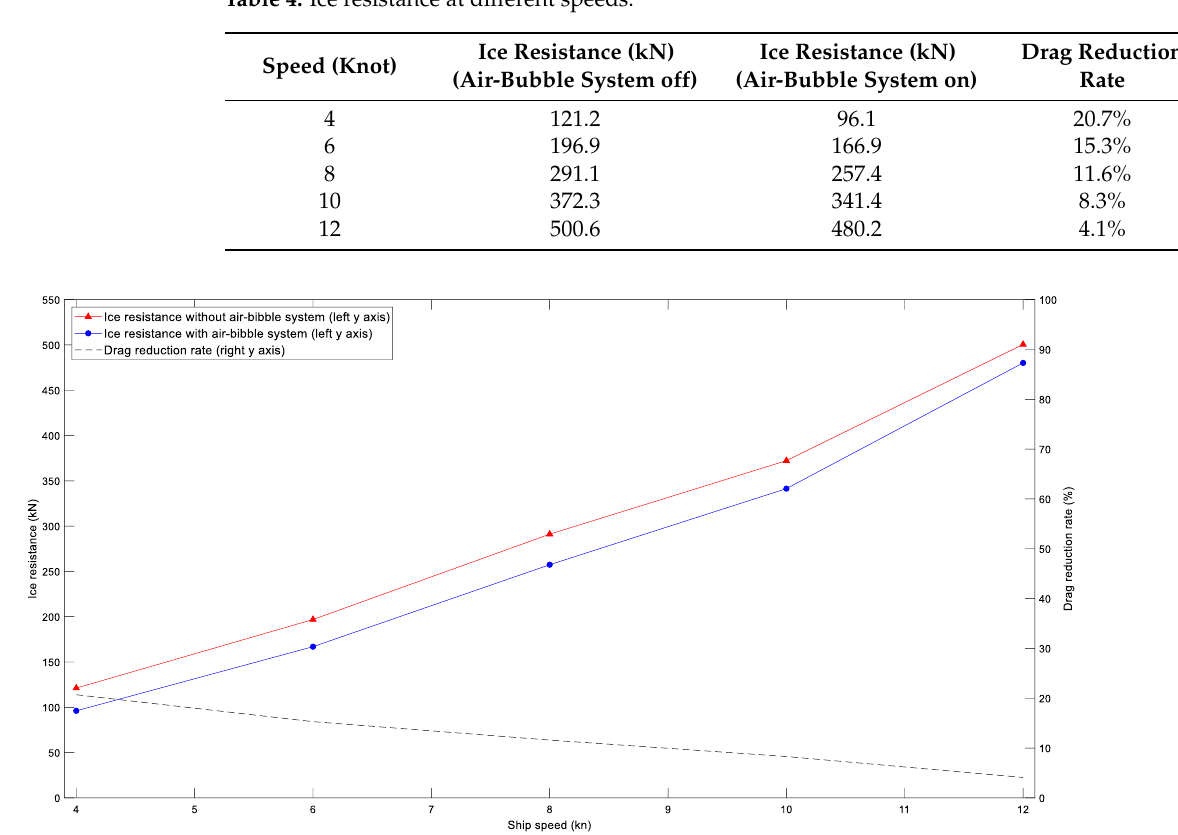
Figure 10. Time series of ice resistance when the air-bubble system is on: ( top ) total ice resistance; (middle) ice resistance from the bow area; ( bottom ) ice resistance from the sides. Table 4. Ice resistance at different speeds.